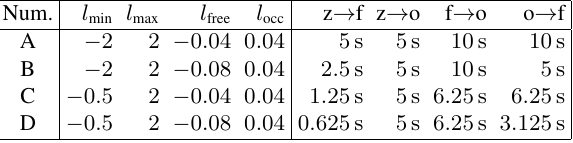
Table 1. Example parameters and the corresponding convergence time for a 10Hz scan frequency. z , f and o denote the states zero knowledge , free and occupied